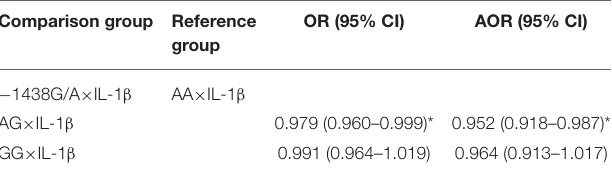
TABLE 9 | Interaction effect between cytokines and 5-HTR2A polymorphisms on sleep quality. Comparison group Reference